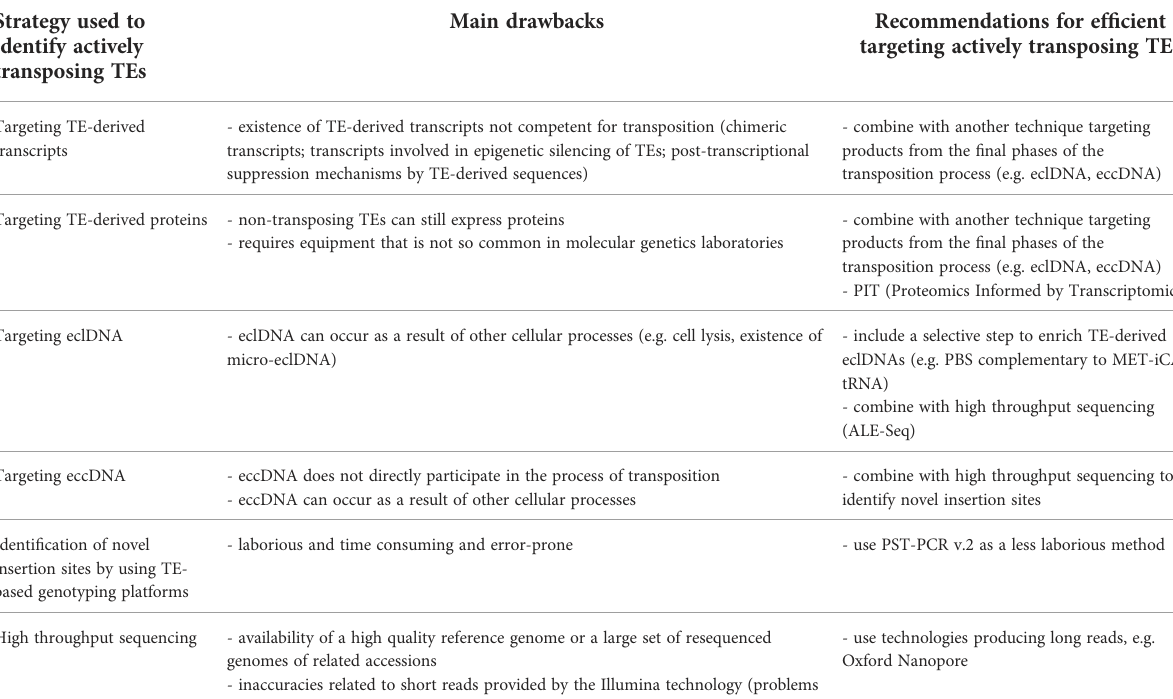
TABLE 1 Summary of approaches used to identify actively transposing elements. Strategy used to identify